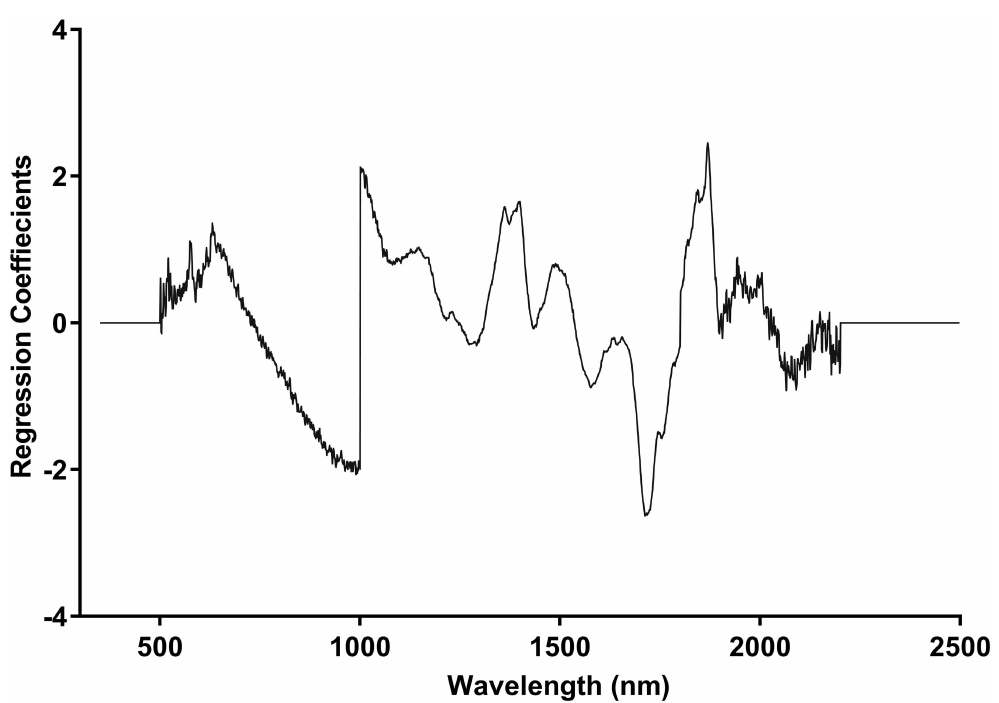
Fig 2. Regression coefficients for predicting the age of female wild-type Ae . aegypti using 9 partial least squares regression factors.